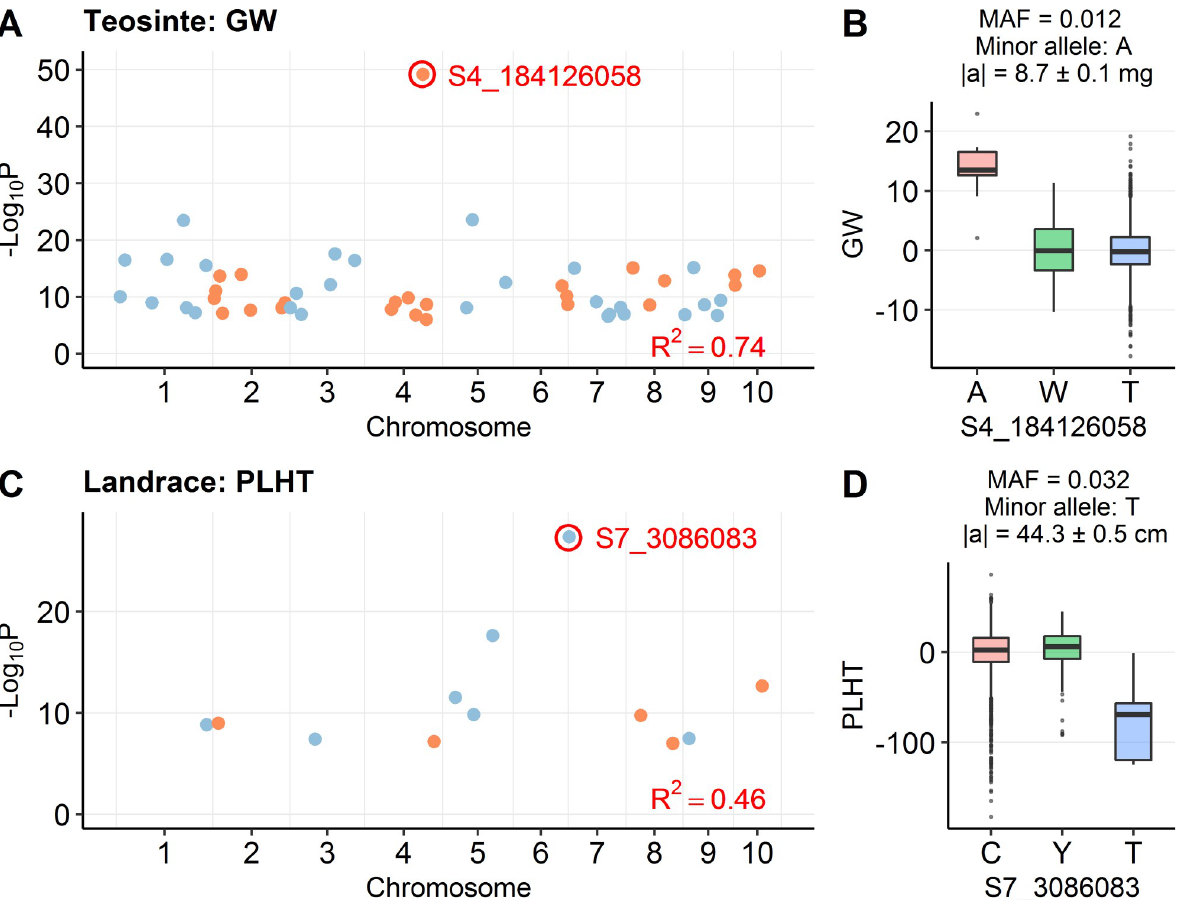
Fig 3. Examples of QTL under mutation-selection balance. (A) The distribution of detected QTL for GW in teosinte. The most significant QTL is labeled as S4_184126058. (B) The phenotypic effect of QTL S4_184126058. (C) The distribution of detected QTL for PLHT in maize landrace. The most significant QTL is labeled as S7_3086083. (D) The phenotypic effect of QTL S7_3086083. In (A) and (C), QTL in different chromosomes are shown in different colors; R 2 stands for r-square explained by overall QTL model. In (B) and (D), the phenotype is shown in residuals after accounting for covariates; |a| stands for absolute additive effect (mean ±